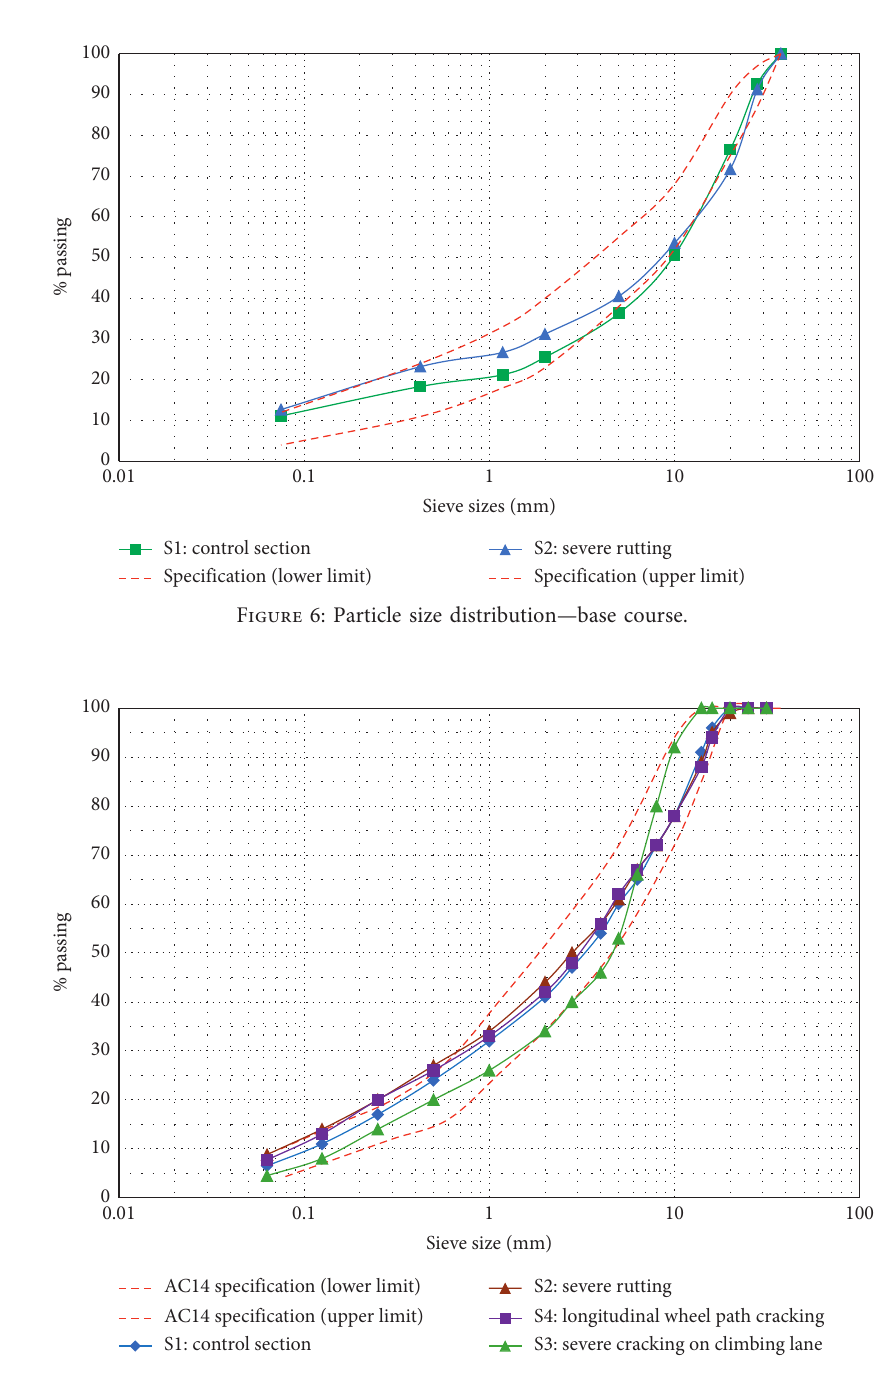
Figure 7: Particle size distribution of wearing course